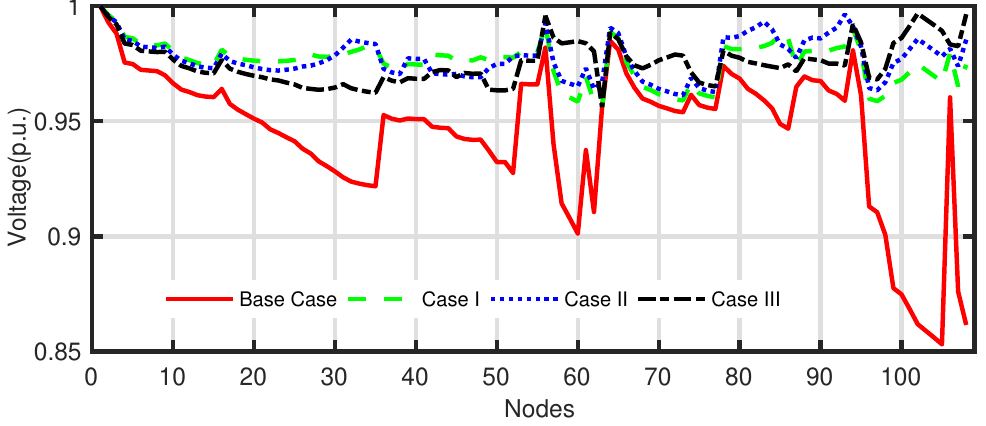
Figure 8. Mean node voltage profiles of 108-bus Indian distribution